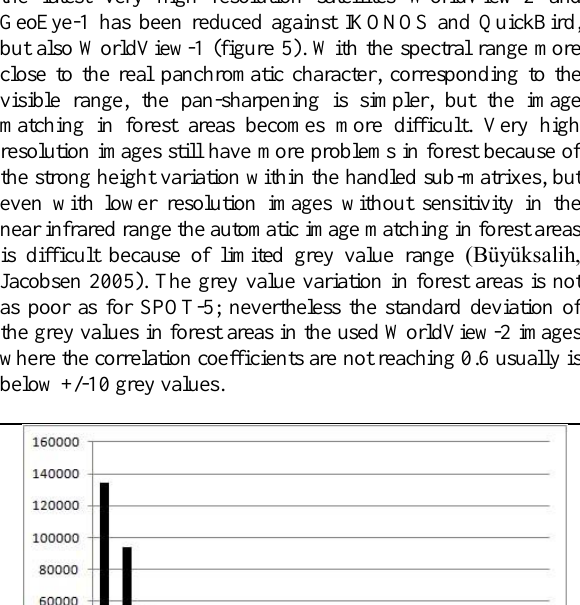
Fig. 7 : color coded size of correlation coefficients in the overview image with 5m GSD, in grey = used image for matching in the area with correlation < 0.6